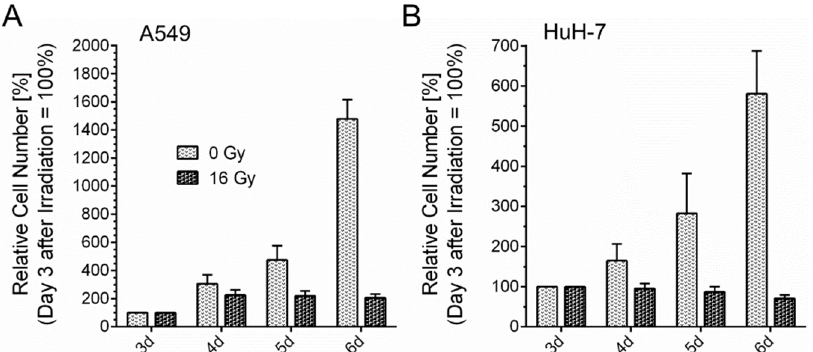
Figure 5. Stopping of proliferation after 16 Gy gamma-irradiation. Proliferation of A549 ( A ) and HuH-7 ( B ) cells was stopped on day four after irradiation. Cell numbers are shown as relative cell numbers with respect to day three (3 d = 100%) after irradiation and compared with normal cell proliferation of untreated control cells of each cell line. Mean values + SD are shown.